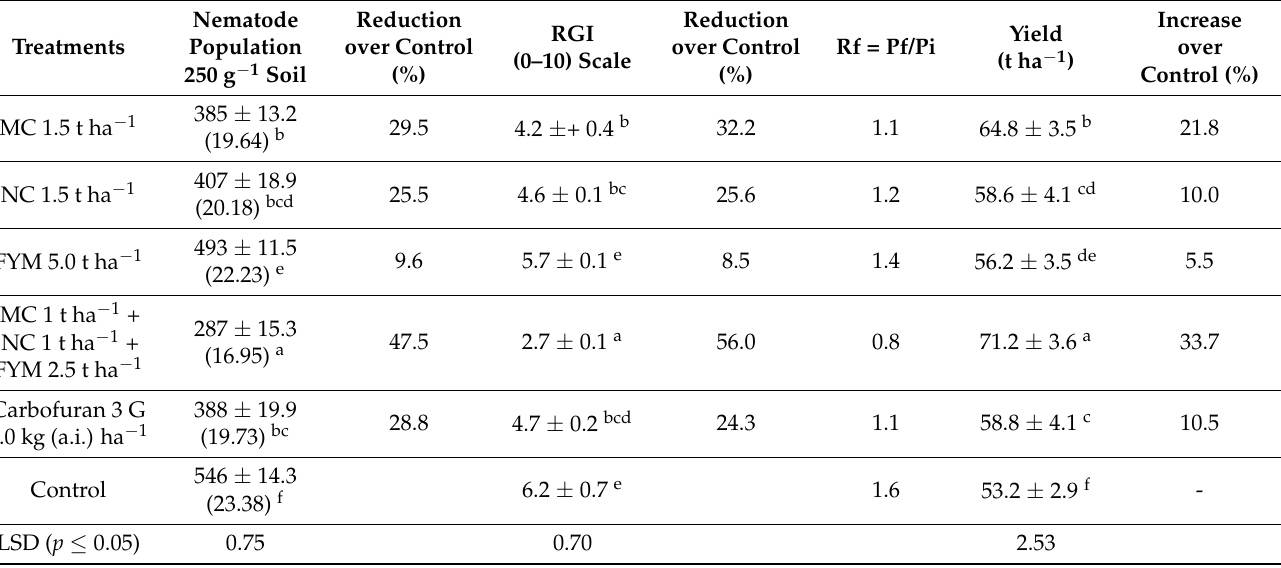
Table 4. Effects of different amendments on root-knot nematode infestation and yield of cucumber (var. Punjab Kheera 1) under polyhouse conditions (polyhouse-II, Department of Vegetable Science).